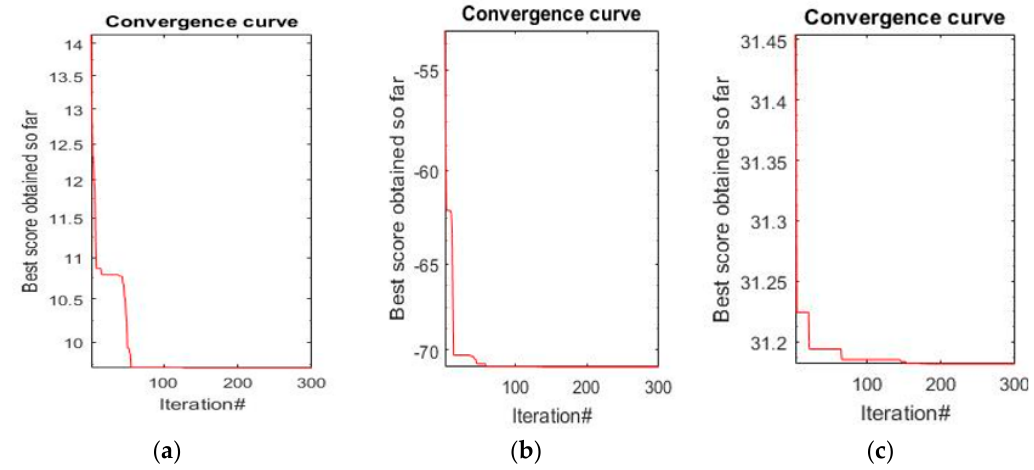
Figure 19. ( a ) The convergence curve of the 3rd hour; ( b ) the convergence curve of the 12th hour; ( c ) the convergence curve of the 19th hour.